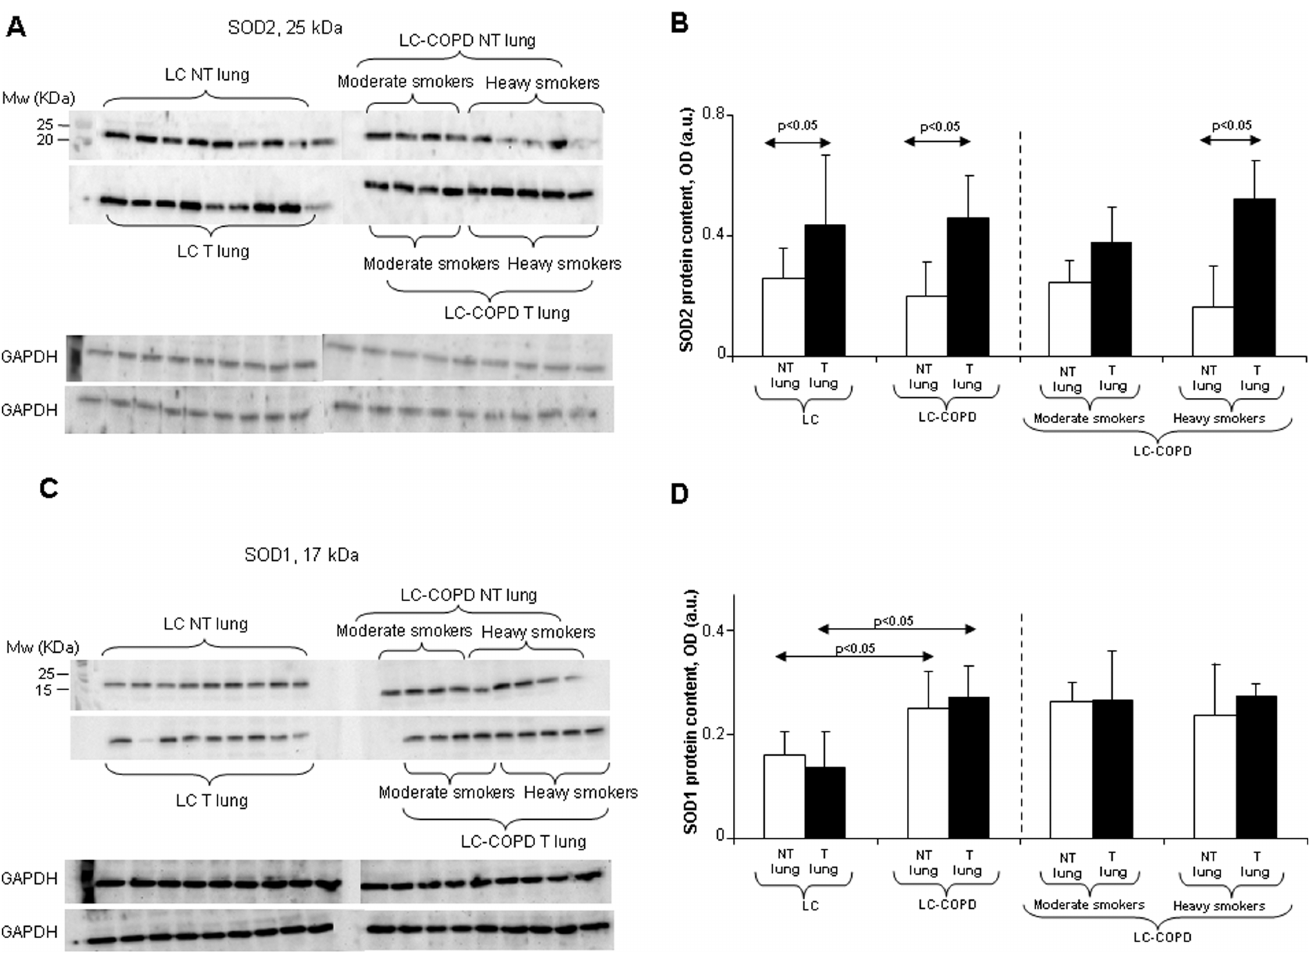
Figure 3. (A) Immunoblots of SOD2 in the lung tumor (T) and nontumor (NT) of LC and LC-COPD patients. SOD2: superoxide dismutase 2; LC: lung cancer; COPD: chronic obstructive pulmonary disease; MW: molecular weights; KDa: kilodaltons. (B) Mean values and standard deviation (optical densities [OD] expressed in arbitrary units [a.u.]) of SOD2 protein content were significantly greater in the tumor lesions (T) compared with nontumor (NT) lungs in LC patients and LC-COPD as a group as well as in LC-COPD heavy smokers. The absence of any statistical sign means that no significant differences were found between groups for the different study comparisons. (C) Immunoblots of SOD1 in the lung tumor (T) and nontumor (NT) of LC and LC-COPD patients. (D) Mean values and standard devia- tion (OD expressed in a.u.) of SOD1 protein content were significantly increased in both tumor (T) and nontumor (NT) lung specimens of LC-COPD patients compared with LC patients. The absence of any statistical sign means that no significant differences were found between groups for the different study comparisons. (E) Immunoblots of catalase in the lung tumor (T) and nontumor (NT) of LC and LC-COPD patients. (F) Mean values and standard deviation (OD expressed in a.u.) of catalase protein content was significantly reduced in the tumor lesions (T) compared with nontumor (NT) lungs in both LC-COPD and LC patients, as well as in LC-COPD heavy smokers. The absence of any statistical sign means that no significant differences were found between groups for the different study comparisons. SOD2, superoxide dismutase 2; MW, molecular weights; KDa,